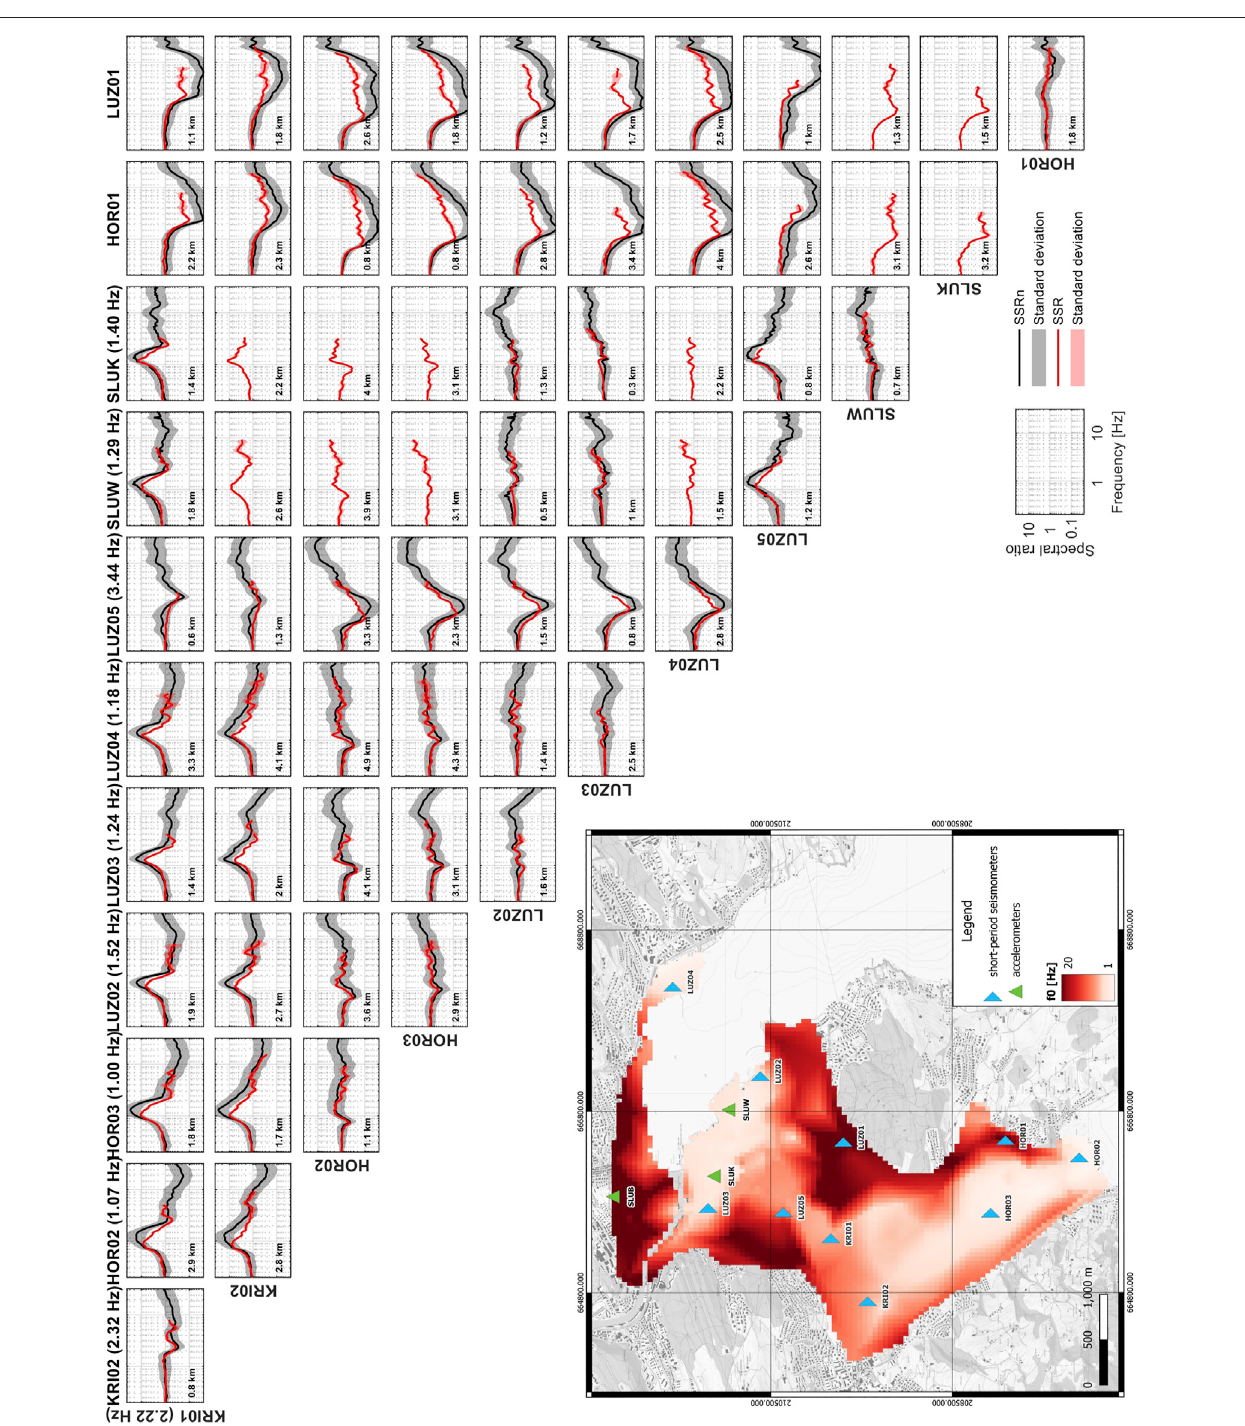
FIGURE 6 | Comparison between SSRn and SSR for all combinations of short-period seismometers. Each column corresponds to one site and each row to one reference station. The distances between sites and f0 values are indicated. In the case of SLUK and SLUW, the short-period seismometers deployed close to the permanent accelerometer were not operating simultaneously with all stations. The map shows the interpolated map of f0; for the rock sites where a peak was indiscernible, the value of 20 Hz was allocated for visualization purposes.